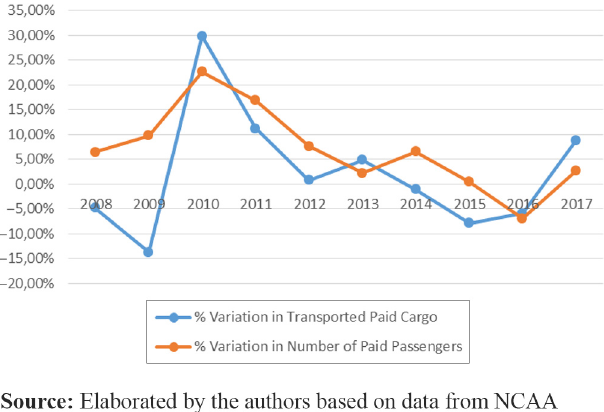
Figure 1. Evolution